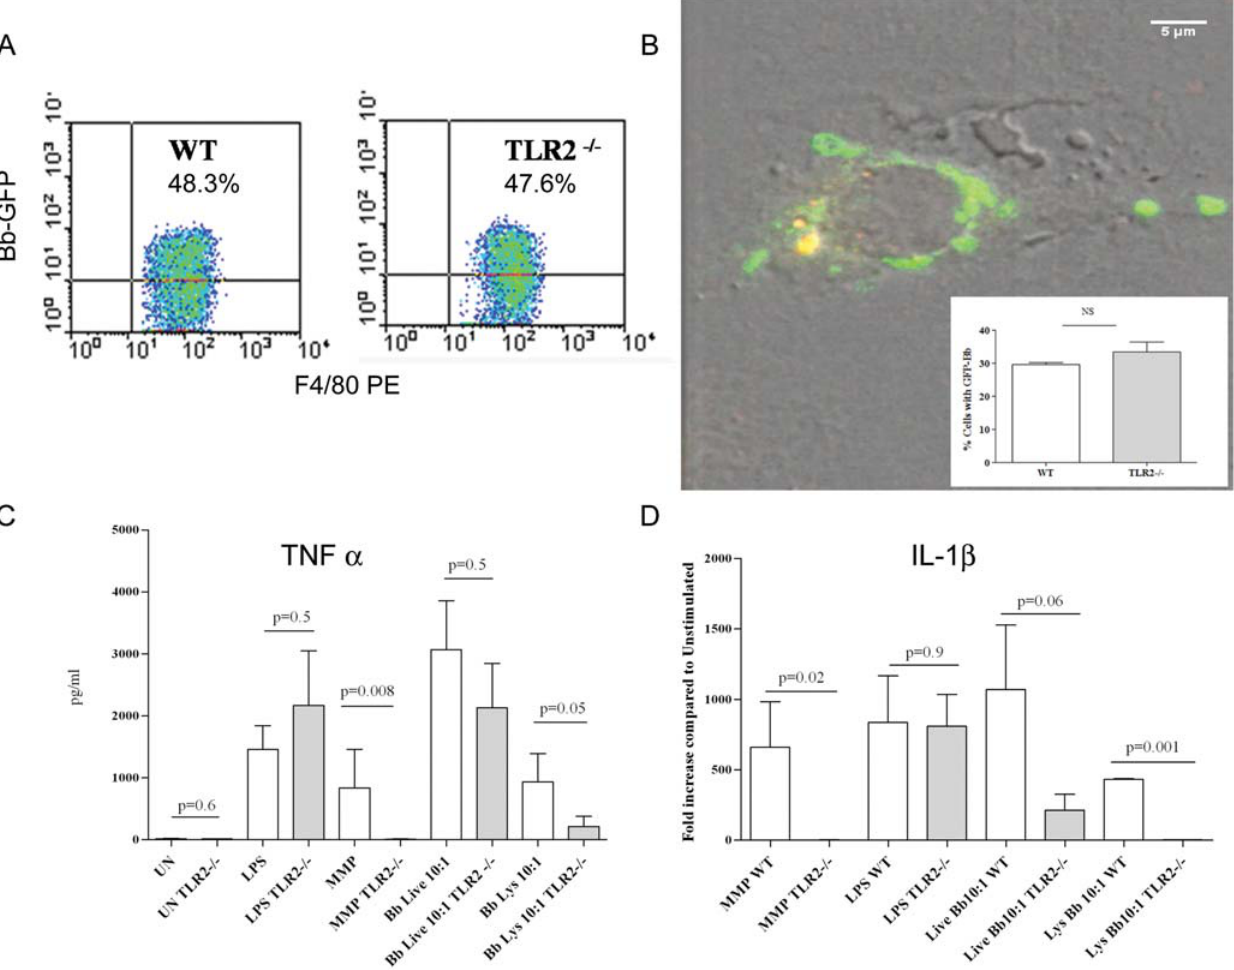
Figure 7. TLR2 deficient and wild type murine macrophages (peritoneal macrophages or bone marrow derived macrophages) internalize Borreliaburgdorferi (Bb), and generate similar cytokine responses. (A) Wild type (WT) or TLR2-deficient (TLR2 2 / 2 ) mouse derived peritoneal macrophages were incubated for six hours with Bb-GFP (MOI 100:1) and analyzed for GFP expression by flow cytometry. Individual macrophage populations shown in the cytograms were selectively gated for analysis based on F4/80 PE expression and Bb-GFP signal. (B) Representative confocal image of internalized Bb-GFP also labeled with lysotracker in TLR2 2 / 2 bone marrow derived macrophages incubated for six- hours with live Bb (MOI 100:1). Inset shows a bar graph depicting the percentage of WT or TLR2 2 / 2 macrophages that had spirochetes contained within phagosomal vacuoles. (C) Murine peritoneal macrophages were stimulated for six-hours with: 100 ng/ml of LPS, 10 m g/ml of Mitogenic Pentapeptide (MMP), live Bb-GFP or spirochetal lysates (MOI 10:1) and compared to unstimulated (UN) cells. The bars represent the average TNF- a concentration (pg/ml) and standard error of the mean calculated from five independent experiments. (D) RNA from similarly stimulated bone marrow derived macrophages (MOI 10:1) was extracted for qRT-PCR pro-IL-1 b quantitation. Fold increase in transcript copies between each of the stimuli is compared to unstimulated cells. Bars depict the means + / 2 standard error of the mean from a minimum of three independent experiments. P values shown in both C and D correspond to the statistical comparison between WT and TLR2 2 / 2 stimulated